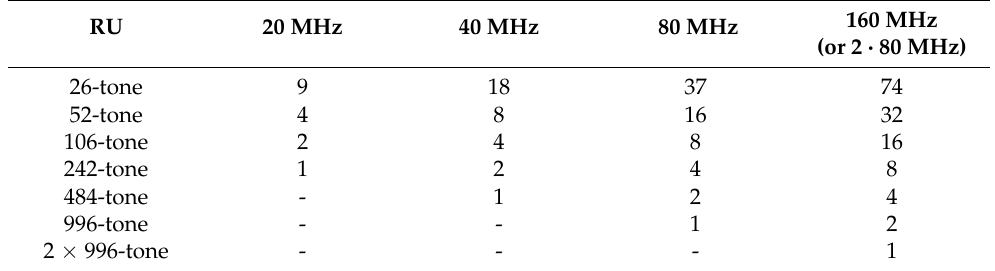
Table 6. RU sizes and their maximum numbers supported by the different channel widths.